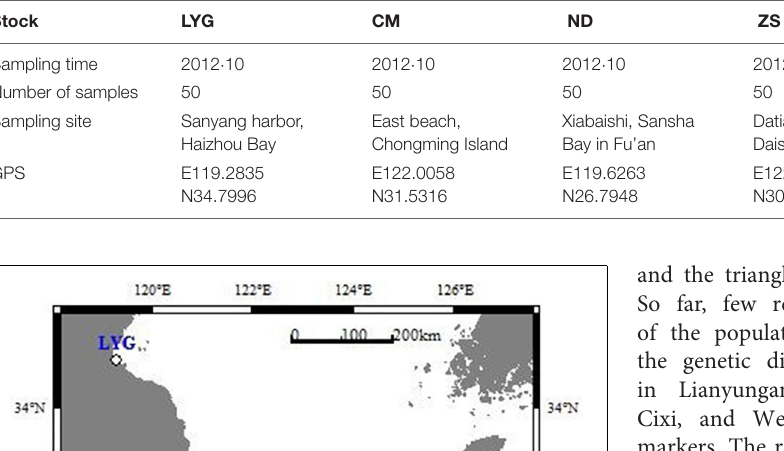
TABLE 1 | Sampling time, place, and sample size of rainbow clam.